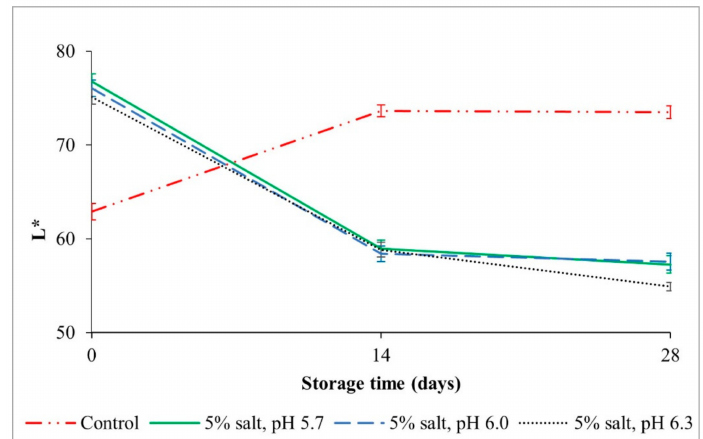
Figure 3. The effect of treatment on L* (CIE lightness coordinate [32]) of frozen-thawed liquid egg yolk. Data are presented with mean ± standard deviation.